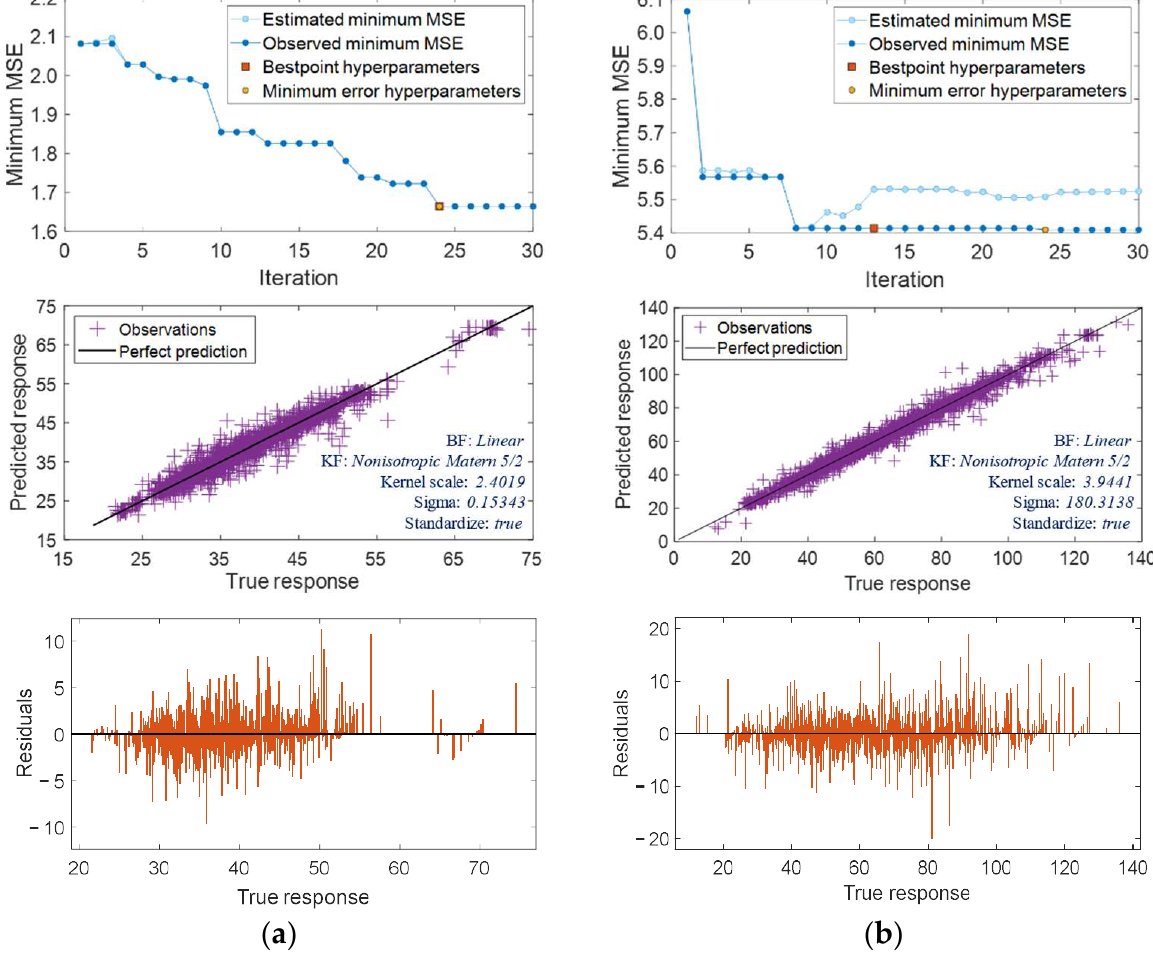
Figure 10. Energy prediction model trained by optimizable GPR with 10 cross-validation folds through 30 iterations: ( a ) cooling demand; ( b ) heating demand.